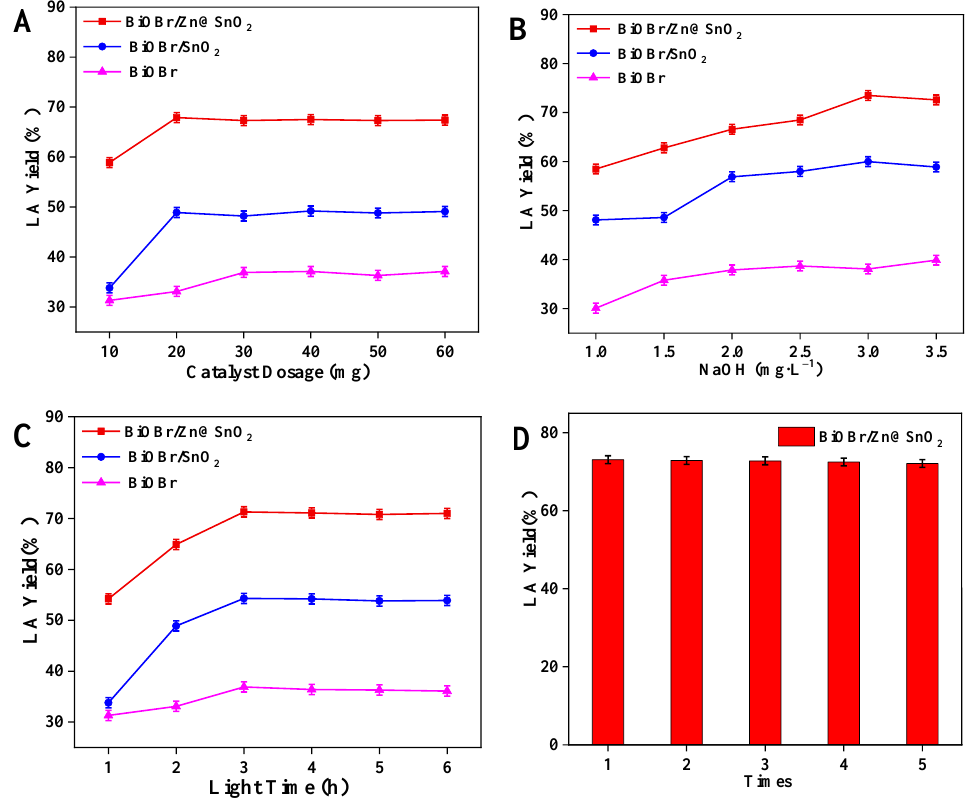
Figure 7. Effect of catalyst type on lactic acid yield ( A ), effect of NaOH concentration ( B ), effect of catalyst dosing ( C ) and reusability of the BiOBr/Zn@SnO 2 ( D ). catalyst dosing ( C ) and reusability of the BiOBr/Zn@SnO 2 ( D